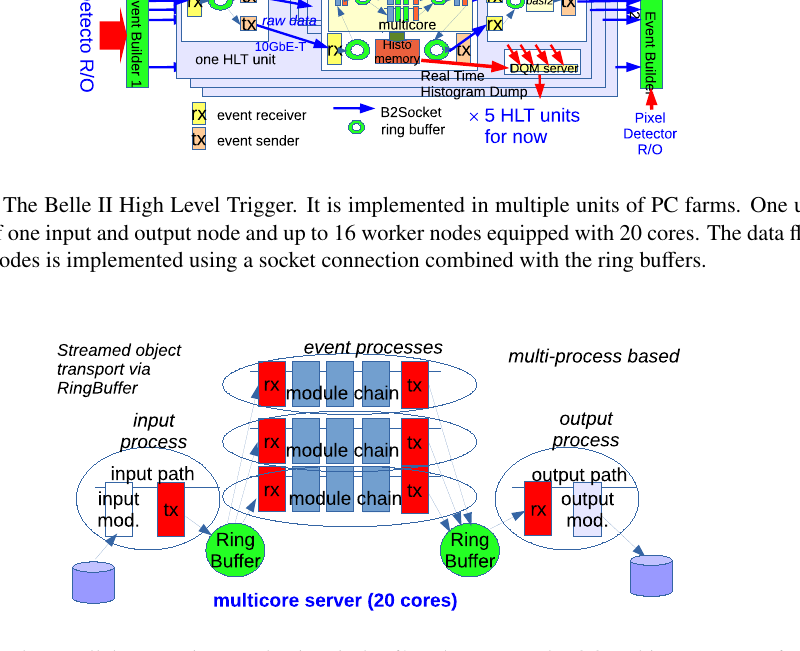
Figure 5. The parallel processing mechanism in basf2. The streamed ROOT objects are transferred among multiple processes over the ring bu ff ers. Each event process receives the data of di ff erent events and the event reconstruction and selection is done in